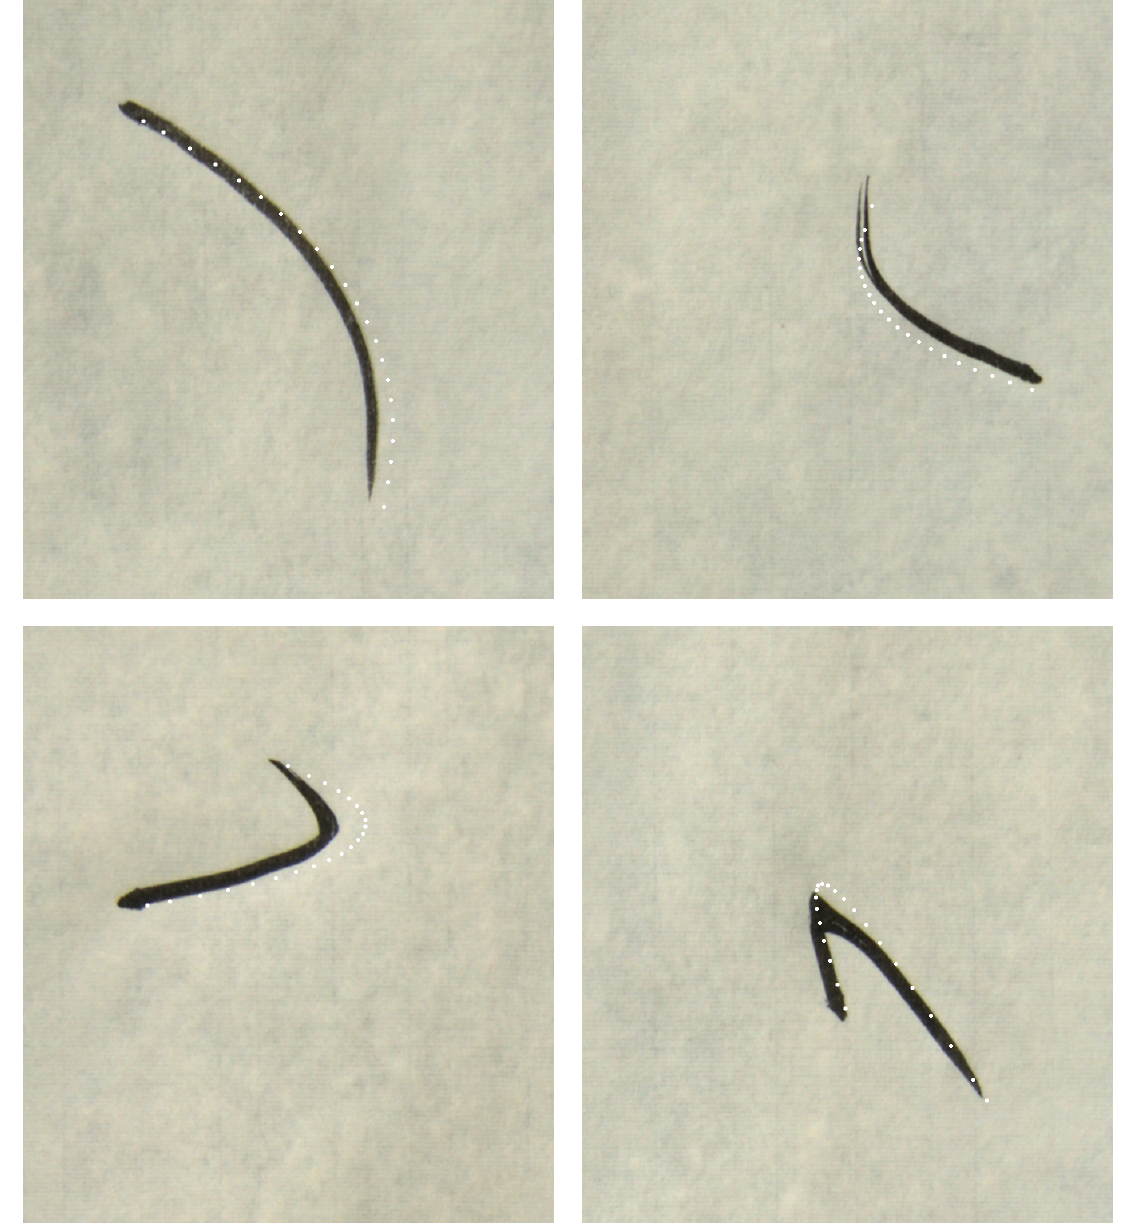
Figure 6. Strokes collected during a run of the recording system. Each rectangle is 10cm × 10cm and the strokes have been generated from random cubic Bézier curves. The white dots indicate the robot tool center point (TCP) path along the canvas and the deviation induced by brush lag is visible. Overall, while new features were introduced, an emphasis has been put on simplification of the design: Previously overengineered solutions made actual painting and maintenance